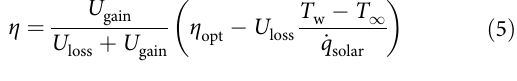
Superimposed in Fig. 4a are the predictions of Eq. (5) for best- fi t